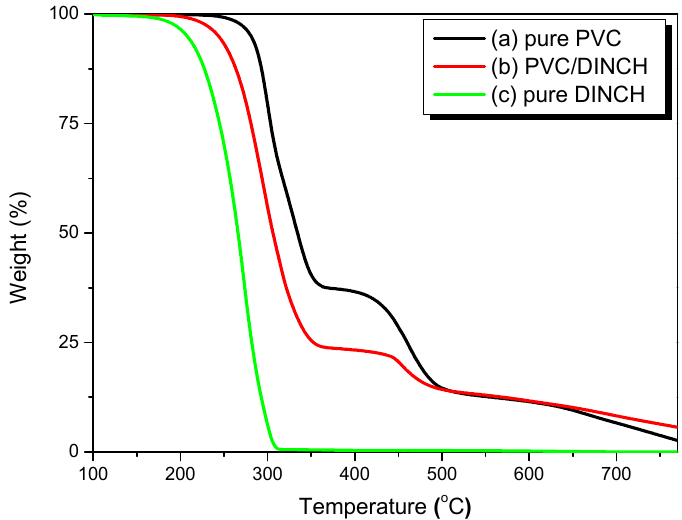
Figure 1. Thermogravimetric analyses (TGA) of (a) the pure PVC, (b) the PVC/DINCH = 100/60 blend, and (c) pure